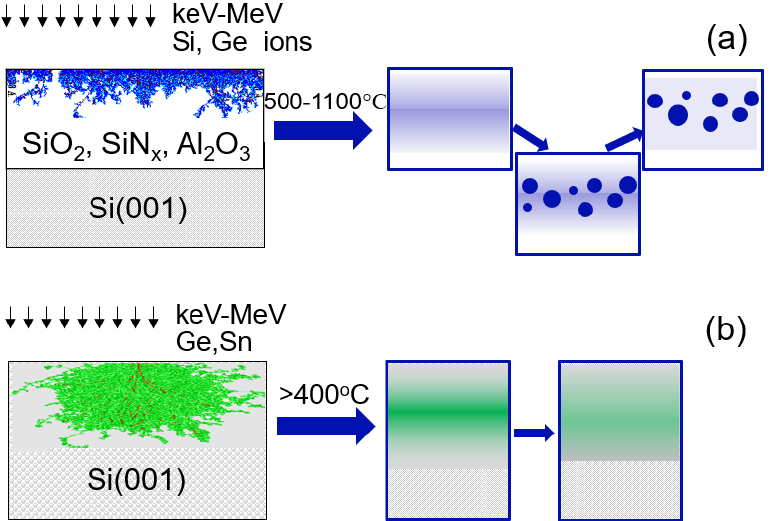
Figure 1. Schematic diagram of ion implantation for the fabrication of ( a ) Si or Ge quantum dots (QDs) in SiO 2 for light emission and ( b ) SiGe and SiGeSn layers for light absorption. ( a ) Supersaturated Si atoms nucleate into QDs when high-temperature processing is applied, and with time, Si atoms adsorb into neighboring QDs, following the transient diffusion mechanism [22]. ( b ) Implanted Ge and/or Sn atoms diffuse and form a crystalline lattice with Si.